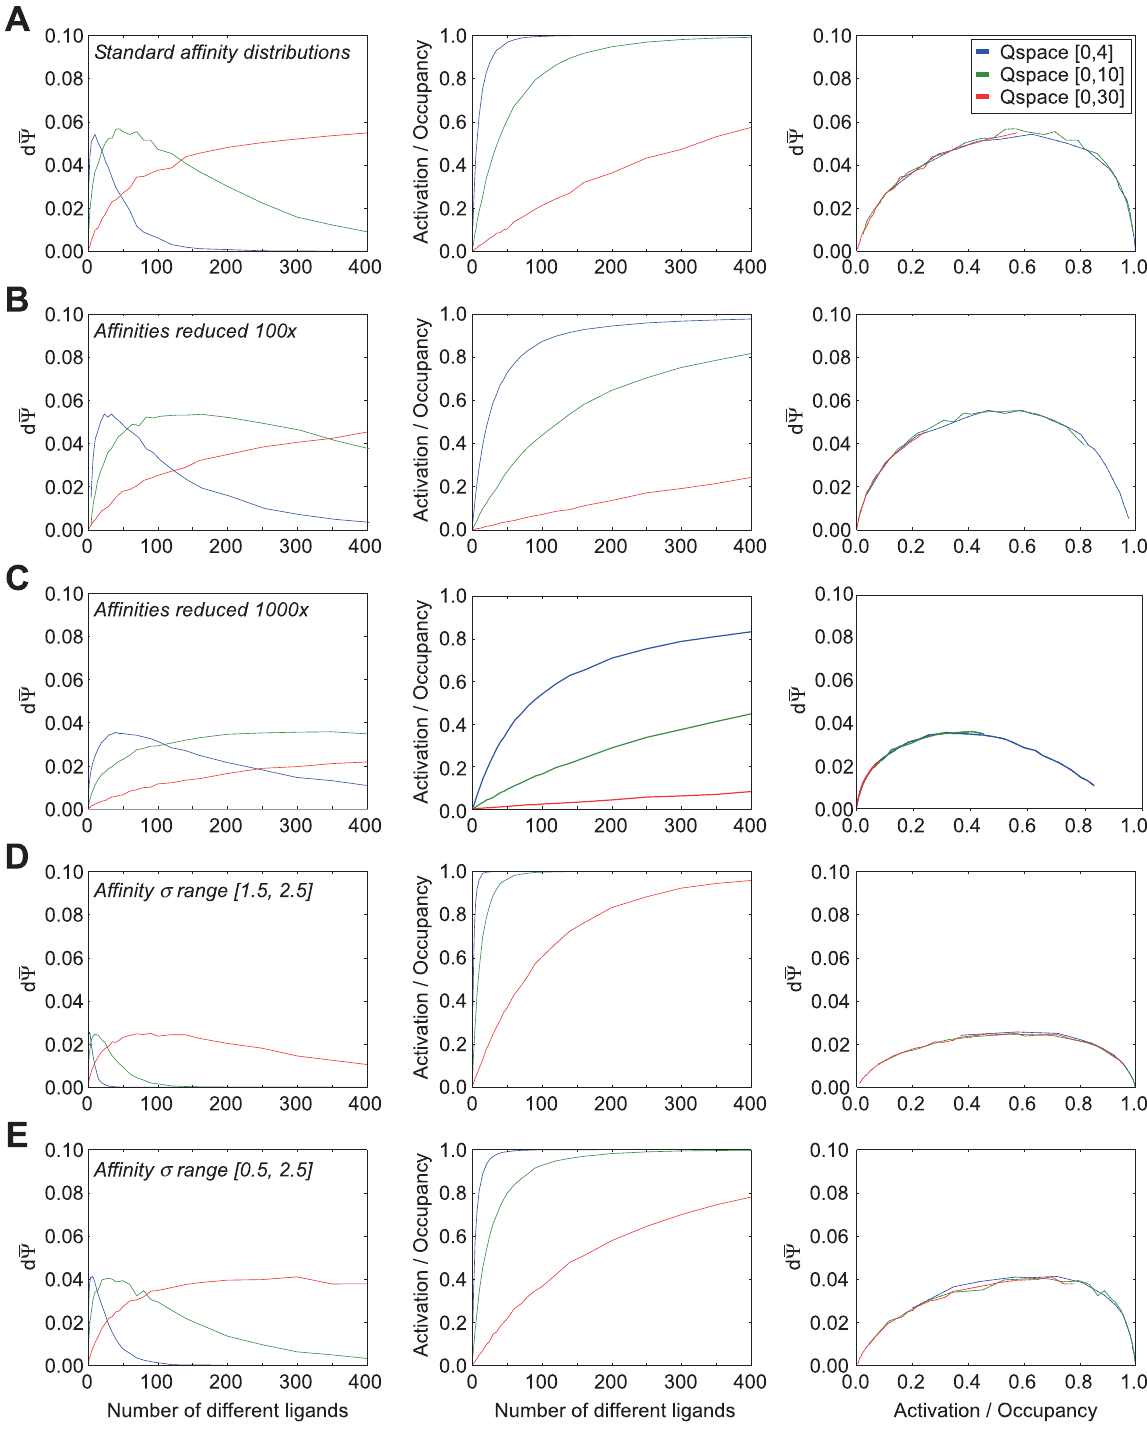
Fig 3. Effects of ligand and receptor densities on receptor activation/occupancy and discrimination capacity, while holding efficacy constant at unity. Because efficacy was held at unity, receptor activation equals receptor occupancy. Thirty receptors were deployed into each of three different Q-spaces in order to vary receptor density without changing the absolute number of receptors. A. Using the standard distribution of affinity Gaussians ( σ = [0.5, 1.5]) and an efficacy of unity, the mean discrimination capacity ( left panel ) and receptor occupancy ( center panel ) were measured as functions of the number of ligands deployed in the space; the two functions also were plotted against one another ( right panel ). B. As panel A, but with affinities uniformly reduced by two orders of magnitude (Gaussian peak affinity K d = 10 − 6 M, asymptotic